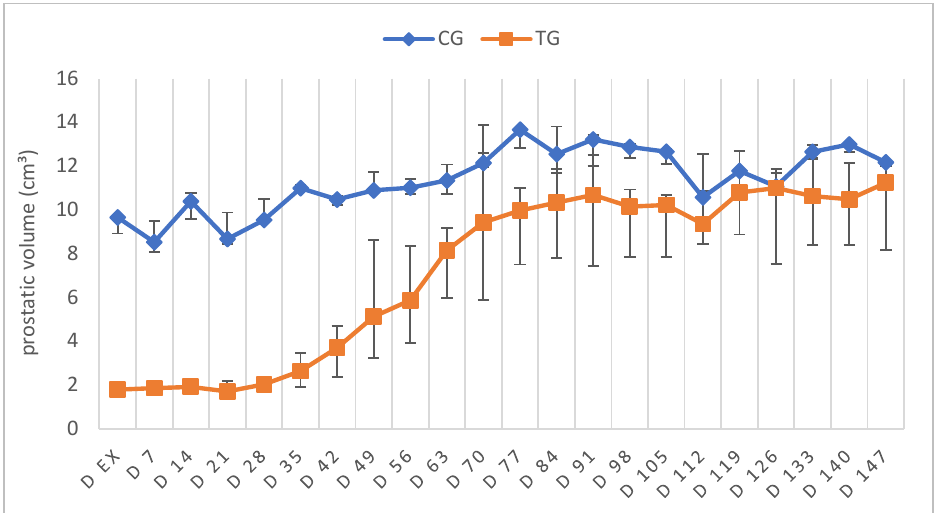
Figure 3. Absolute prostatic volume given as median (Q1, Q3) over time of animals treated with a 4.7 mg deslorelin implant ( TG, n = 6) and saline-treated control animals ( CG, n = 3 ).